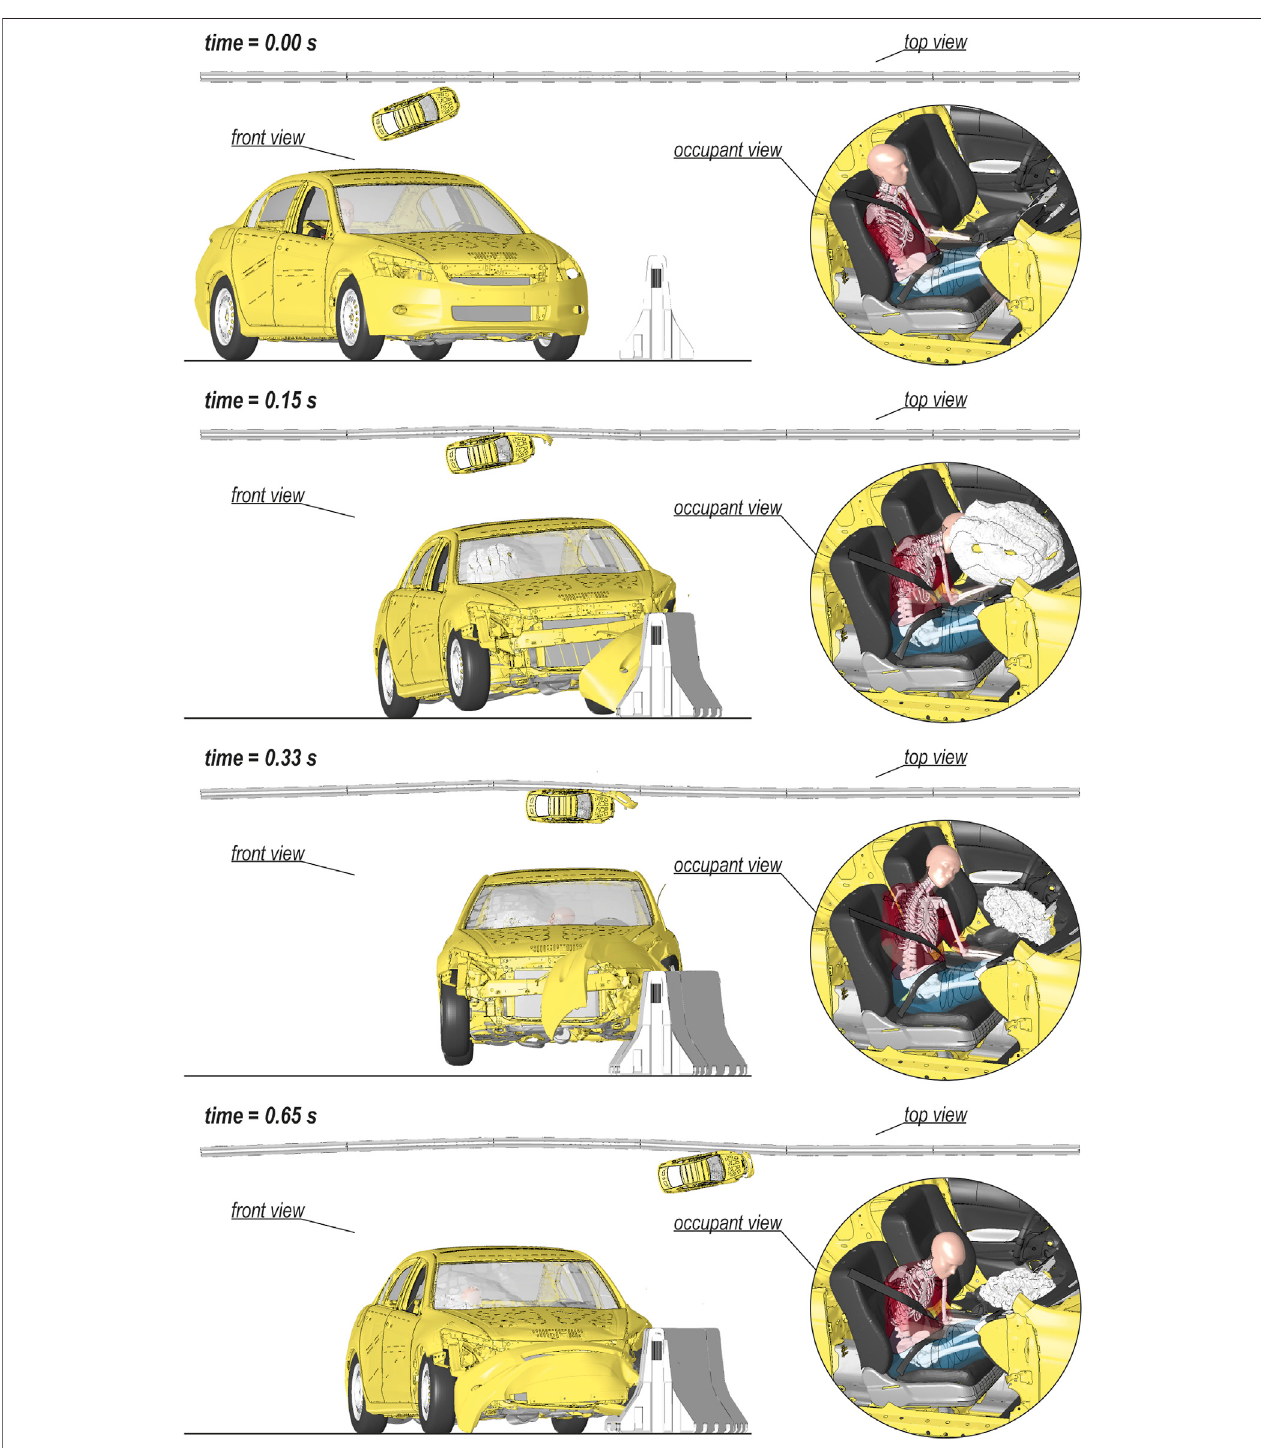
FIGURE 4 | Different views on the selected time instances of the car collision with the H2W5B concrete RSB.